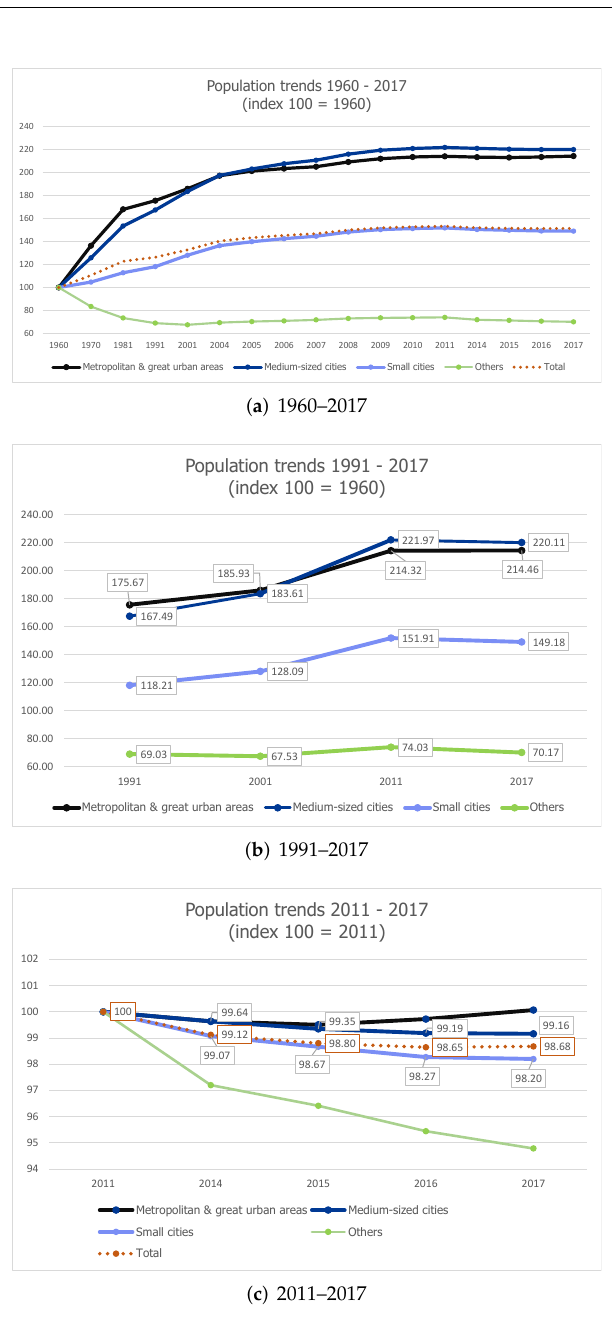
Figure 1. Population trends in Spain considering the Functional Urban Areas